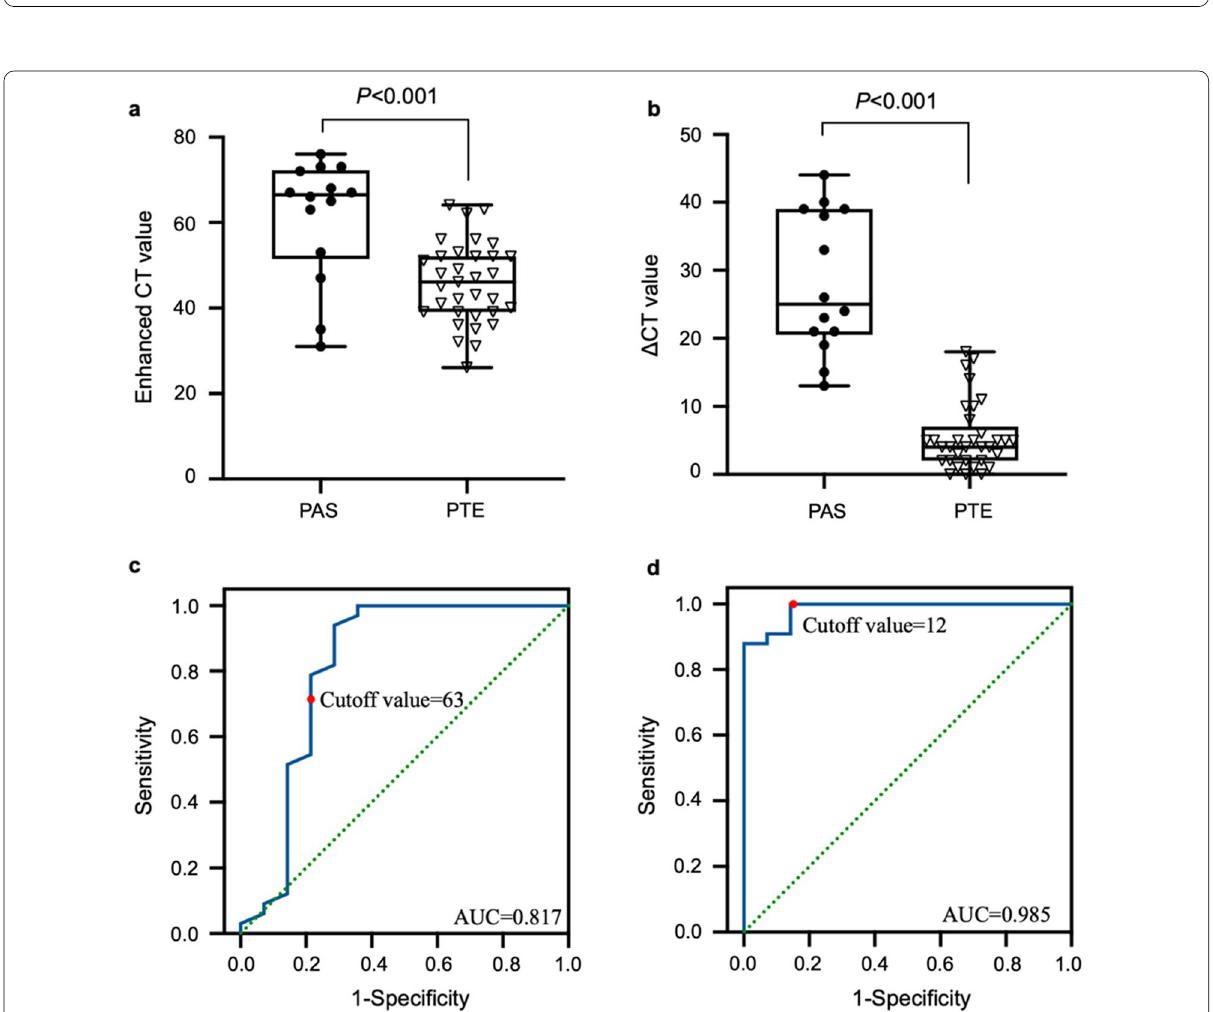
Fig. 6 The differences in enhanced CT ( a ) and ΔCT ( b ) values between PAS and PTE groups ( P < 0.001). Using ROC to identify the best cutoff value of enhanced CT ( c ) and ΔCT ( d ) for distinguishing PAS from PTE,